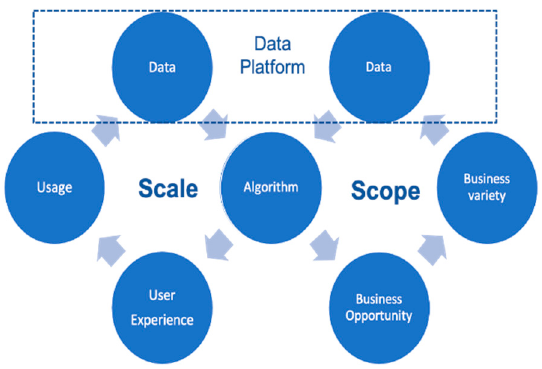
Figure 1. Virtuous growth cycle of AI.